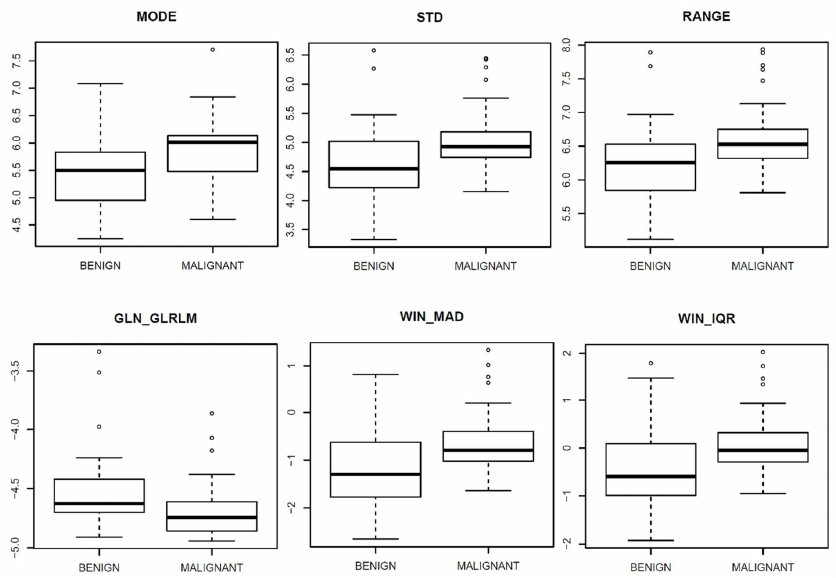
Figure 3. Boxplots of significant textural and dynamic features with AUC values. The best performance (ACC = 0.78; SENS = 0.68; SPEC = 0.88; PPV = 0.84; NPV = 0.74; AUC = 0.78) using textural features was reached with all 48 metrics and an LDA trained Table 6. Performance of the best classifiers using textural, morphological and dynamic features alone and then together. with balanced data (with ADASYN function).